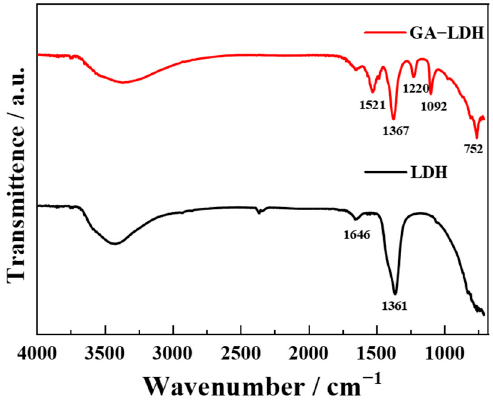
Figure 5. FT − IR spectra of LDH and GA − LDH.